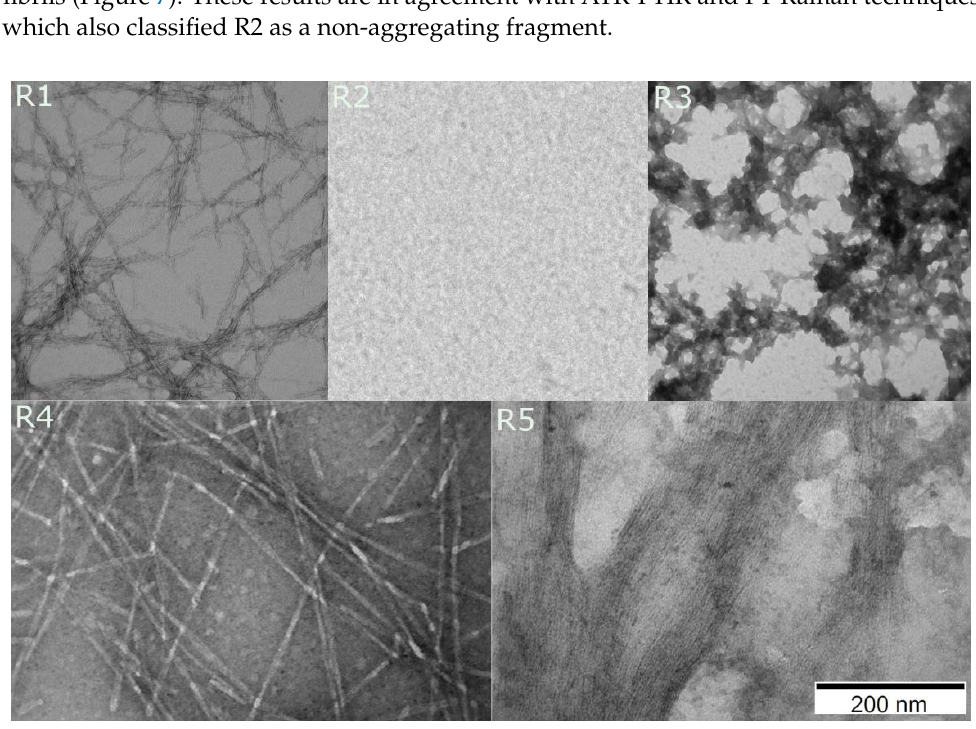
Figure 7. Electron micrographs of S. enterica fragments after one to seven days of incubation in 37 °C. Images registered at the magnification of 200 nm. Peptide concentration was 0.5